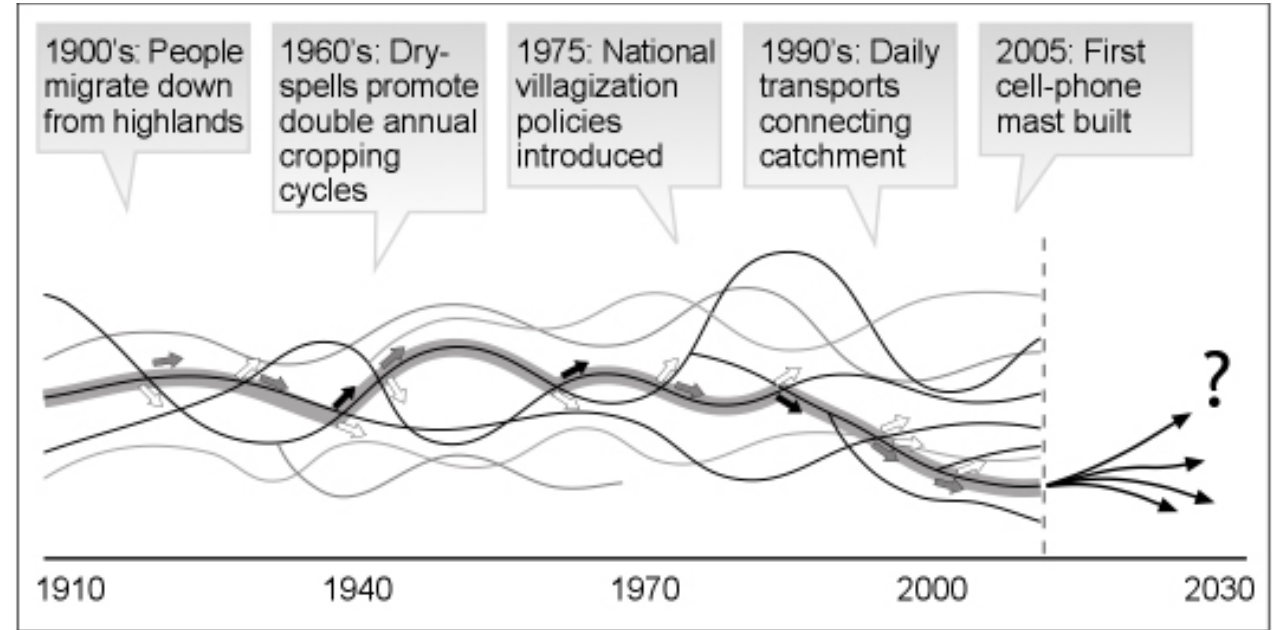
Fig. 2. Schematic illustration of the development path in Makanya catchment. The highlighted line symbolizes Makanya’s development path over the past century. The other lines symbolize alternative pathways that may have been possible. Social, political, economic, and environmental events and processes shape the development trajectories of social–ecological systems, determining which path will be followed and when a system will change trajectory. Some examples of important events that have shaped Makanya’s development are shown in the boxes. Black arrows symbolize points in time when the development has changed its course, gray arrows symbolize a continuation of existing pathway, and white arrows symbolize alternative pathways that may have been possible but were not followed. Over the past decade(s), a number of dramatic changes have been taking place in Makanya, raising questions about the future development trajectory in the catchment, as indicated by the arrows pointing toward year